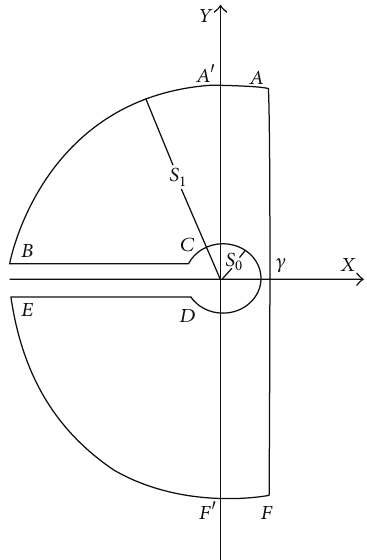
Figure 1: Contour for the inverse